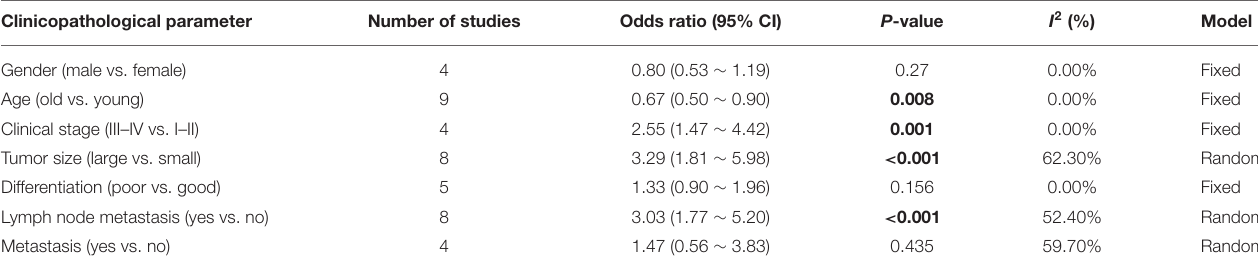
TABLE 2 | Meta-analysis of the association between LINC00511 expression and clinicopathological characteristics. Clinicopathological parameter Number of studies Odds ratio (95% CI) P -value I 2 (%)